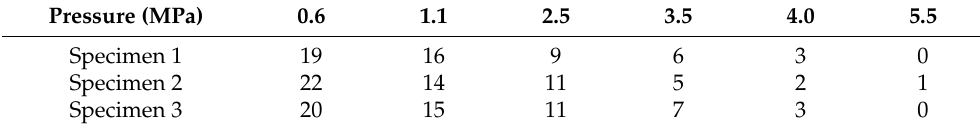
Figure 18. Deep drawing of steel-composite sandwich with blank-holding pressure of 5.5 MPa: ( a ) front view, ( b ) back view. Table 4. Wrinkle number of steel-composite sandwich under different blank-holder pressure.